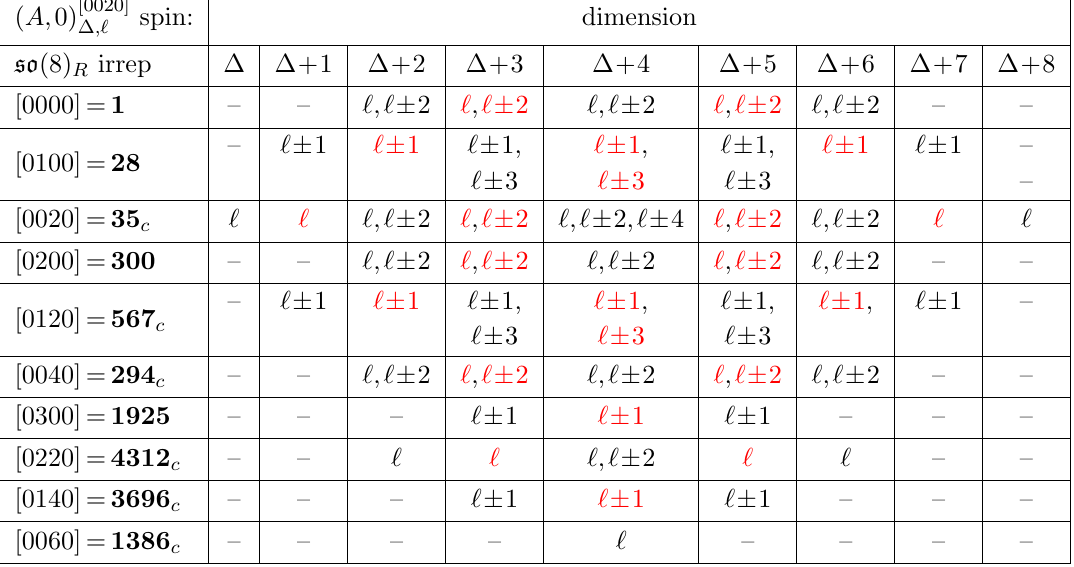
Table 30 . All possible conformal primaries in S 3 (cid:2) S 3 corresponding to the ( A; 0) [0020] formal